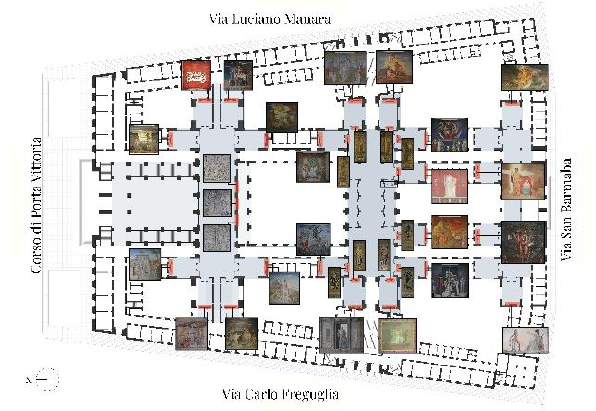
Fig 8. Identification of the artworks, third floor.